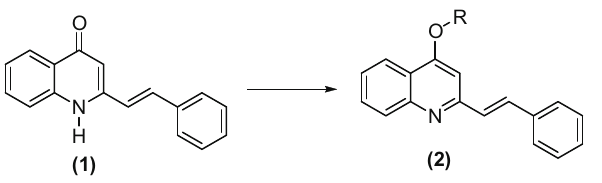
Figure 2: O - Alkylation of the 2 - styryl quinolone [ 8 – 12 ] .